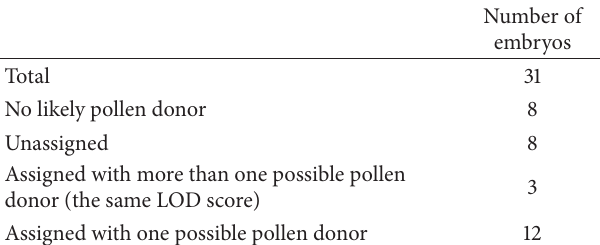
Table 3: Number of embryos unassigned, assigned with more than one, and assigned only with one selected pollen